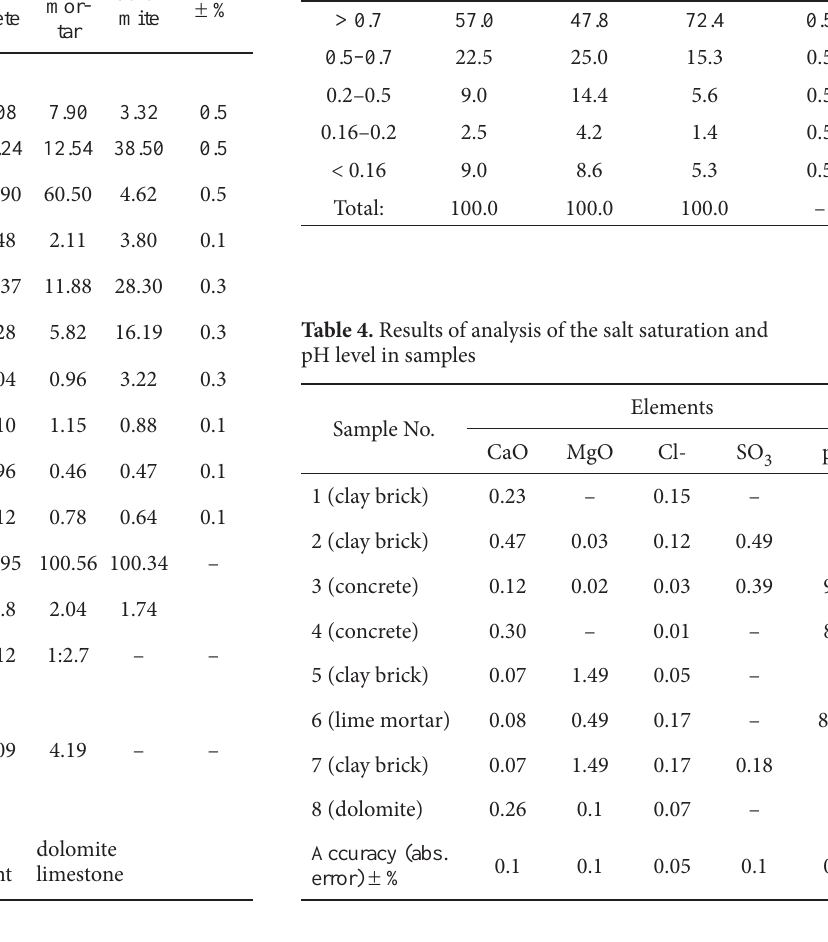
Table 2. Chemical composition of samples in % of mass Elements